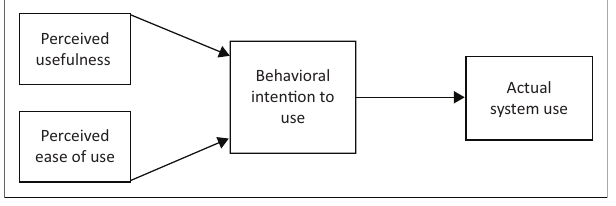
FIGURE 1: Davis’ conceptual model for technology acceptance.